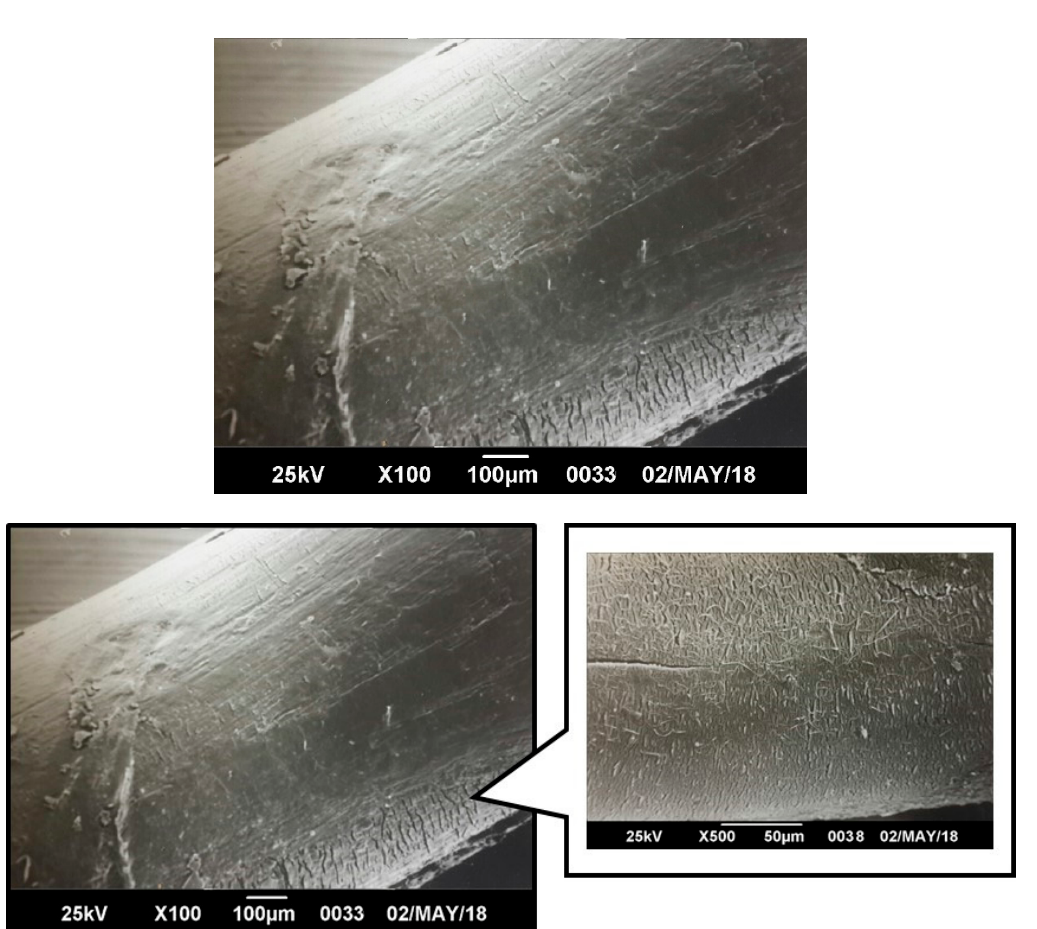
Figure 15. SEM micrographs of PLA 100 fiber surface morphology degraded for 12 weeks at pH = 8.50 and T = 37 °C, where a detail of surface degradation is shown.